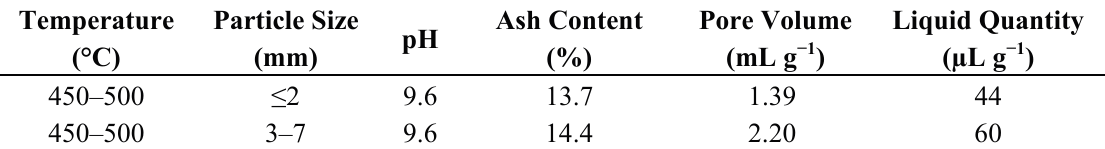
Table 2. Biochar physical